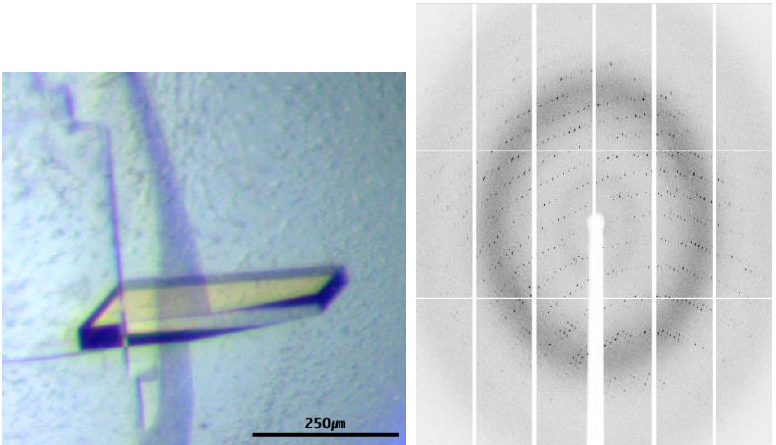
Figure 3. Representative crystal image ( left ) and diffraction pattern ( right ) of Ha Est1. The crystal has final dimensions of 0.6 × 0.5 × 0.2 mm.